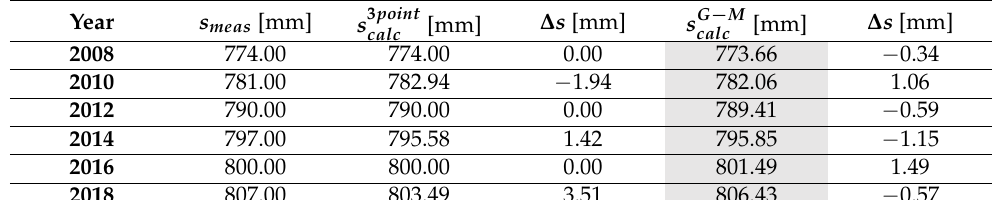
Table 5. Results of the subsidence obtained using the three-point method s 3 point s G − M equalization algorithm for point 121. calc